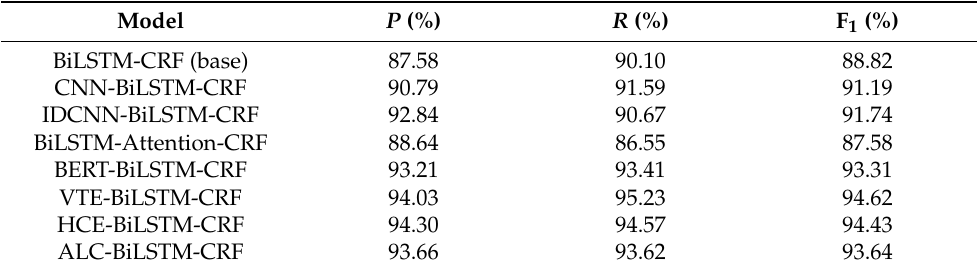
Table 6. The experimental results between different